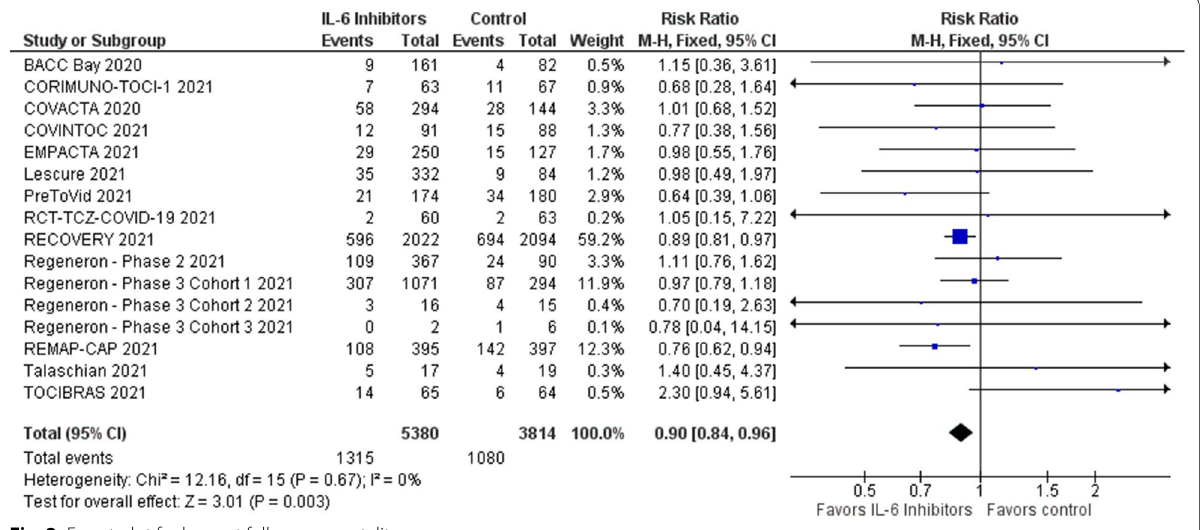
Fig. 2 Forest plot for longest follow-up mortality